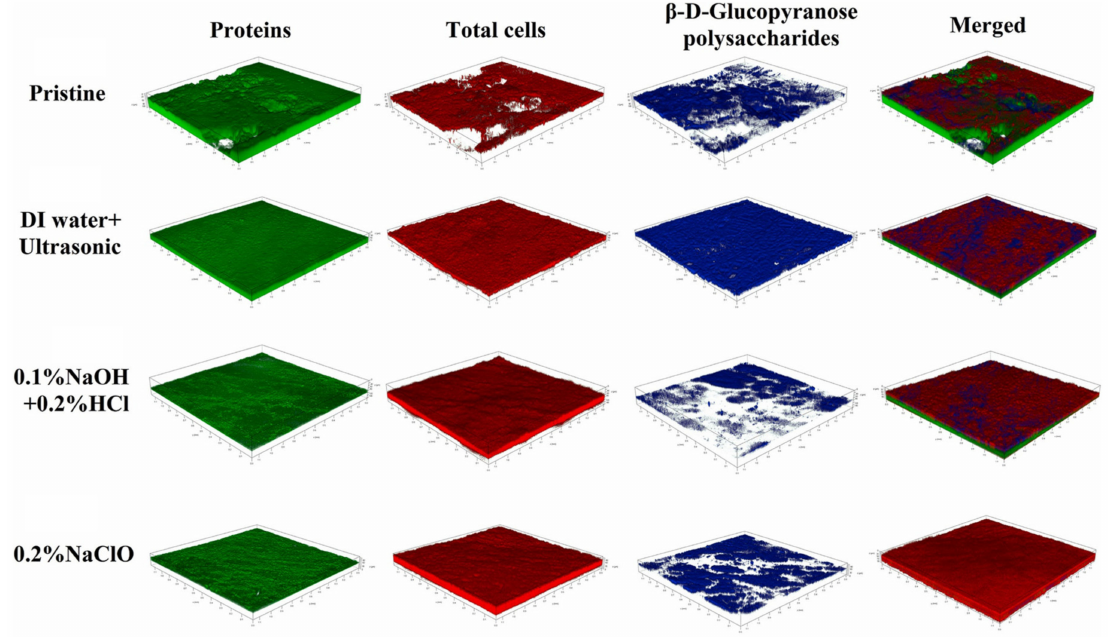
Figure 25. Confocal laser scanning microscopy image of fouled (pristine) FO membrane and the same membrane after ultra-sonication and chemical cleaning using 0.1% NaOH/0.2% HCl or 0.2% NaClO. The images show distribution of individual foulants (green for proteins; red for total cells; blue for polysaccharides) and their superposition (merged). Reproduced from